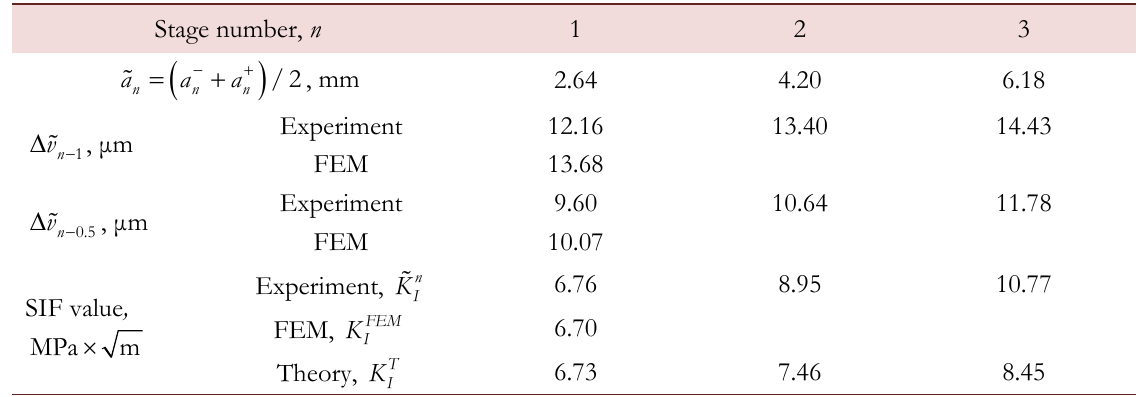
Table 3: Deformation and force fracture mechanics parameters for specimen